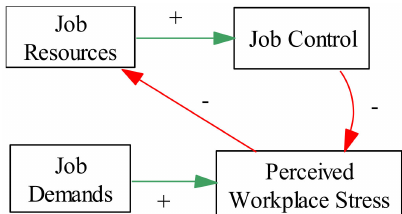
Figure 5. Jetha et al. (2017) model [39] presented in a casual loop diagram. Note: green arrows indicate positive causal relations, and red arrows indicate negative causal